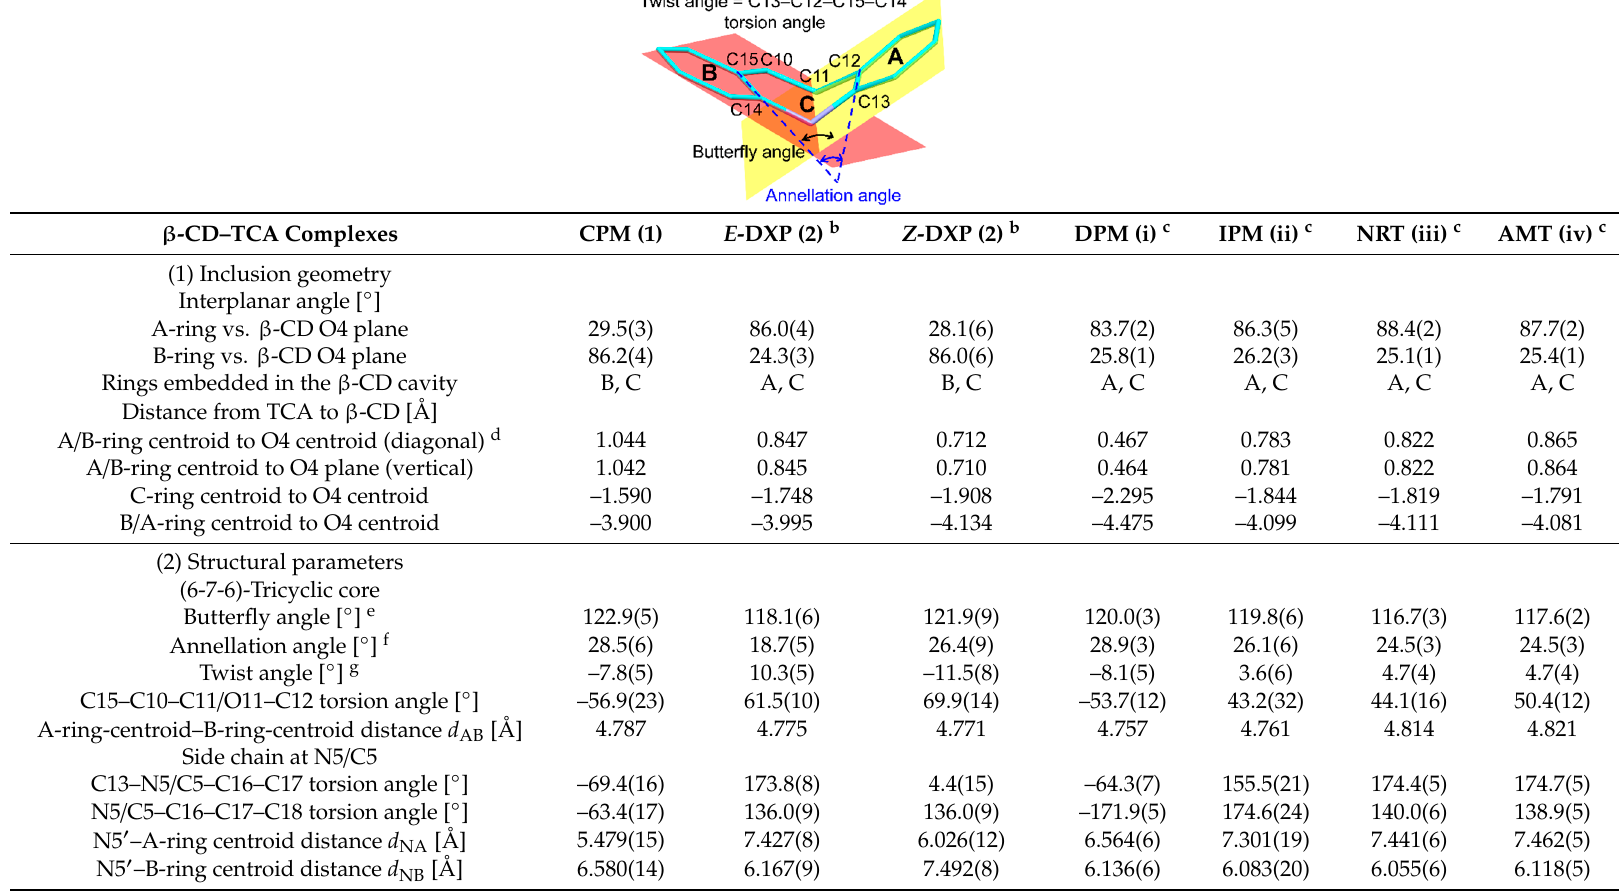
Table 1. Insightful comparisons of inclusion geometries and structural parameters of six TCAs encapsulated in the β -CD cavity, CPM ( 1 ), E -, Z -DXP ( 2 ), DPM